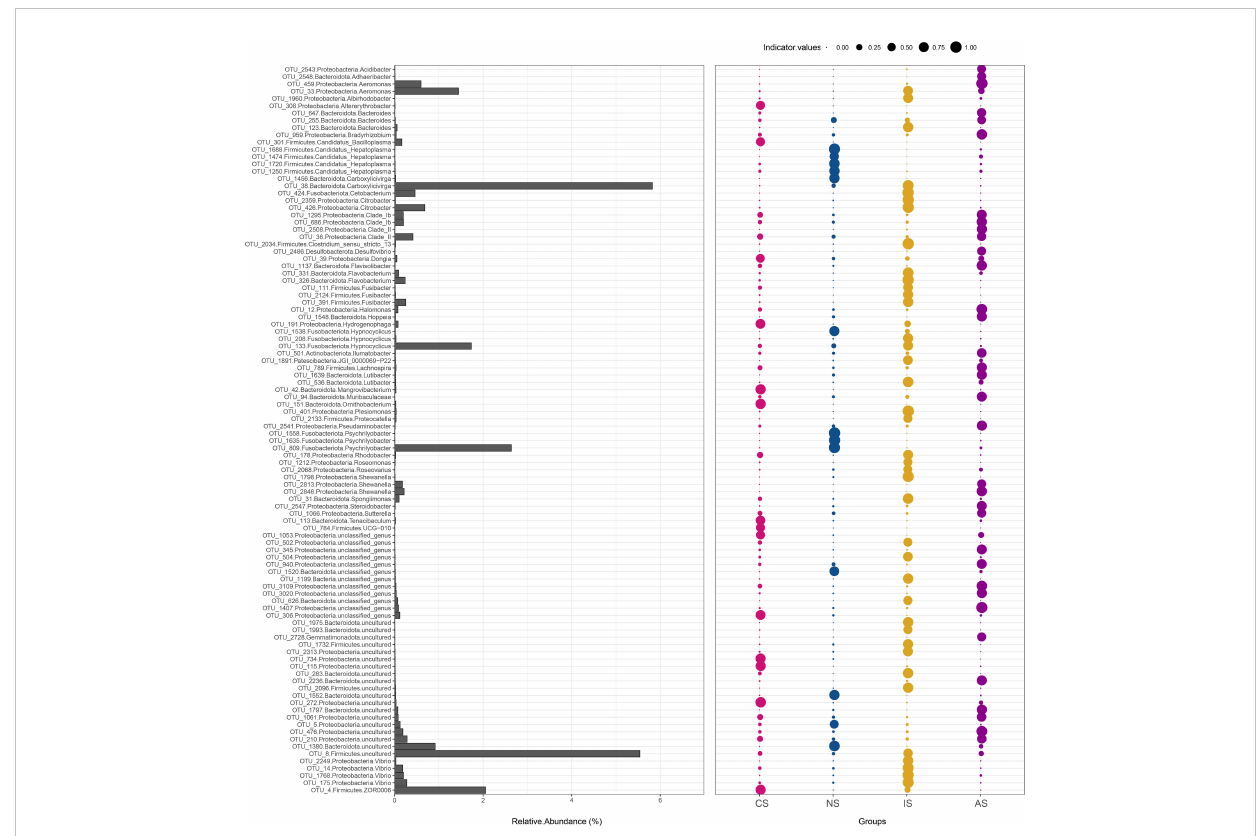
FIGURE 5 Gut bacterial indicators in response to multiple low salinity modes. The bar graph represents the relative abundance of each OTU, and the bubble size represents the indicator value of each species in the sample group, that is, the indicative size of the species in the